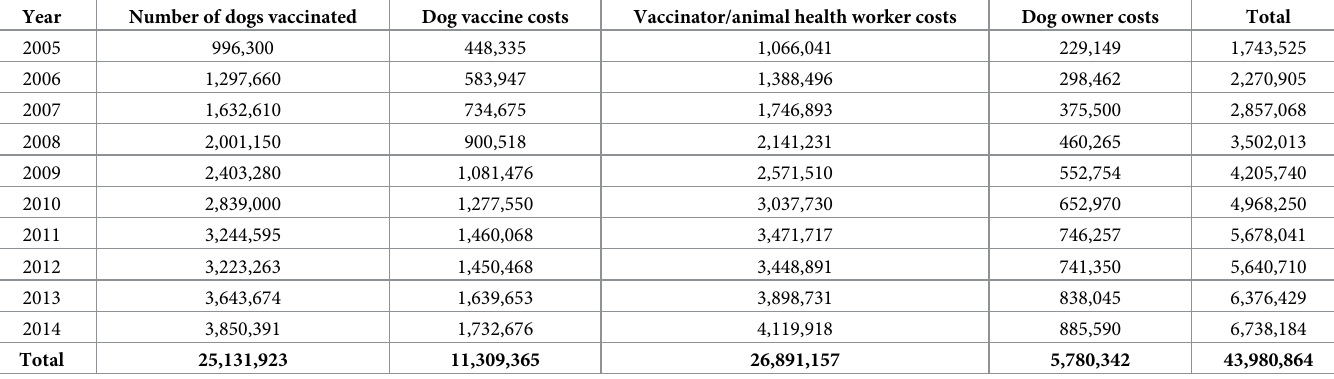
Table 9. Costs (in 2017 USD) of canine rabies prevention in Viet Nam between 2005 and 2014.